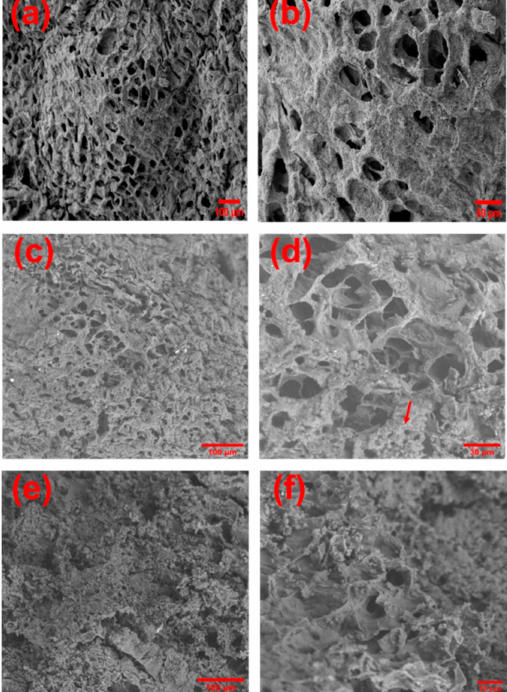
Figure 6. Morphology of freeze-dried hydrogels. Representative SEM images of ( a , b ) PASP hydrogel, ( c , d ) PASP:9DAB:10PEDOT hydrogel, and ( e , f ) [PASP/PEDOT]PHMeDOT ( θ = 10 h). Micrographs recorded with ( a ) 100 × , ( b ) 250 × , ( c ) 450 × , ( d ) 1k × , ( e ) 450 × , and ( f ) 2k × magnifications are